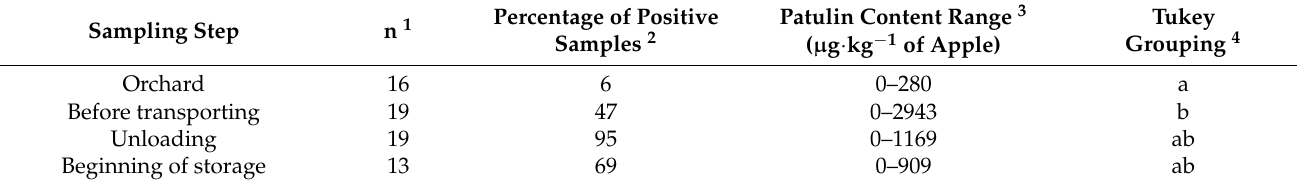
Figure 2. Culturable bacteria, yeast and mold populations on the surface of apples collected at different steps of the apple cider production chain before transformation into juice. The results are expressed as log 10 CFU/g of apple, determined by plate counting on three different growth media. The values are the average of a duplicate experiment of 27 apple samples collected at the orchard and 19 apple samples collected at the four final steps (including apples treated individually, by group of 5 and by group of 15), total number of apples analyzed = 225. The different letters denote homogeneous groups revealed by post-hoc tests ( p ≤ 0.05) done for the culturable populations of each microbial type throughout the different sampling steps. Table 2. Patulin content in apple samples collected at different steps of the apple cider production